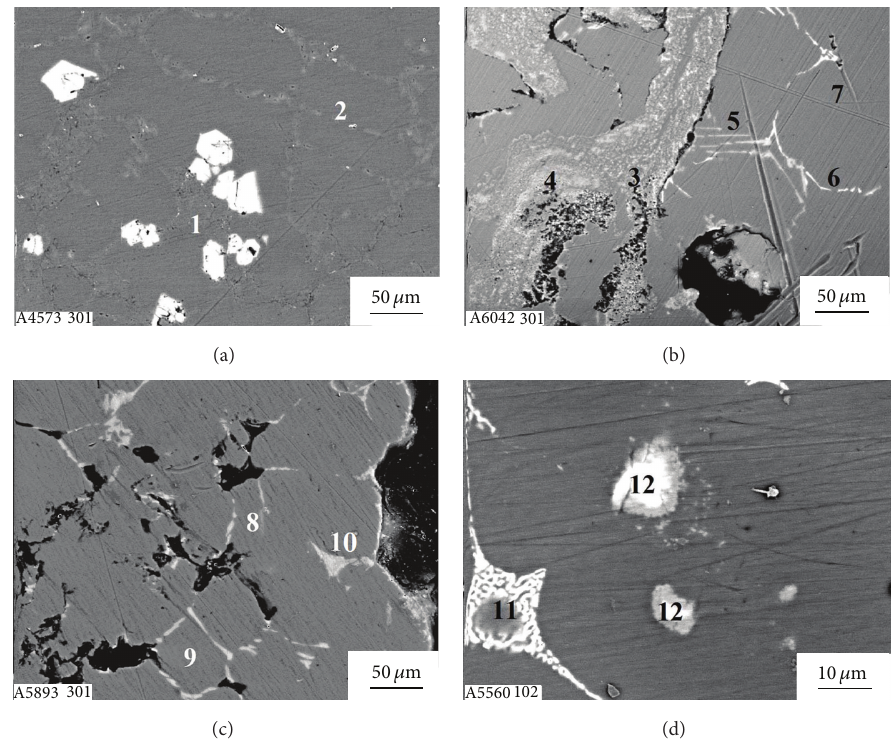
Figure 1: SEM micrographs of cell wall materials for Al-foams processed either with (a) CaCO 3 or with (b)–(d) TiH 2 and performed (a)–(c) with and (d) without Ca additive and performed with different parent alloys: (a) Al-7Si (F5), (b) Al-1Mg-0.6Si (F7), (c) Al-5Mg (F9), and (d) Al-Zn-Mg